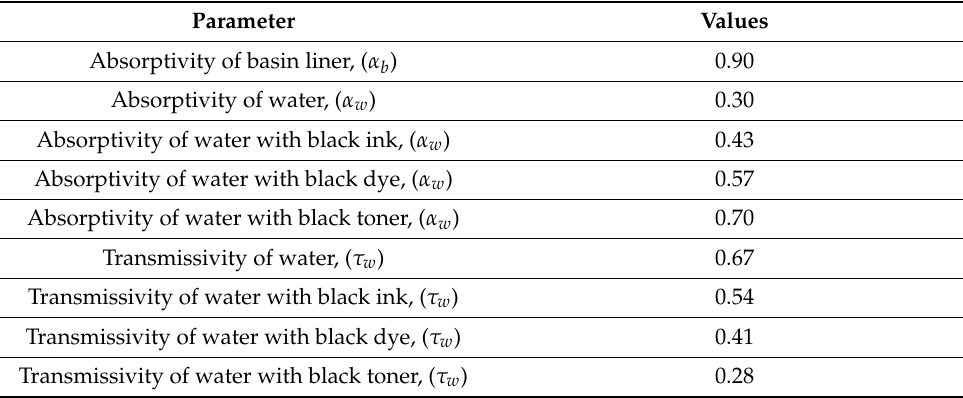
Figure 1. Schematic diagram of a single-slope solar still. Table 1. The model specifications.